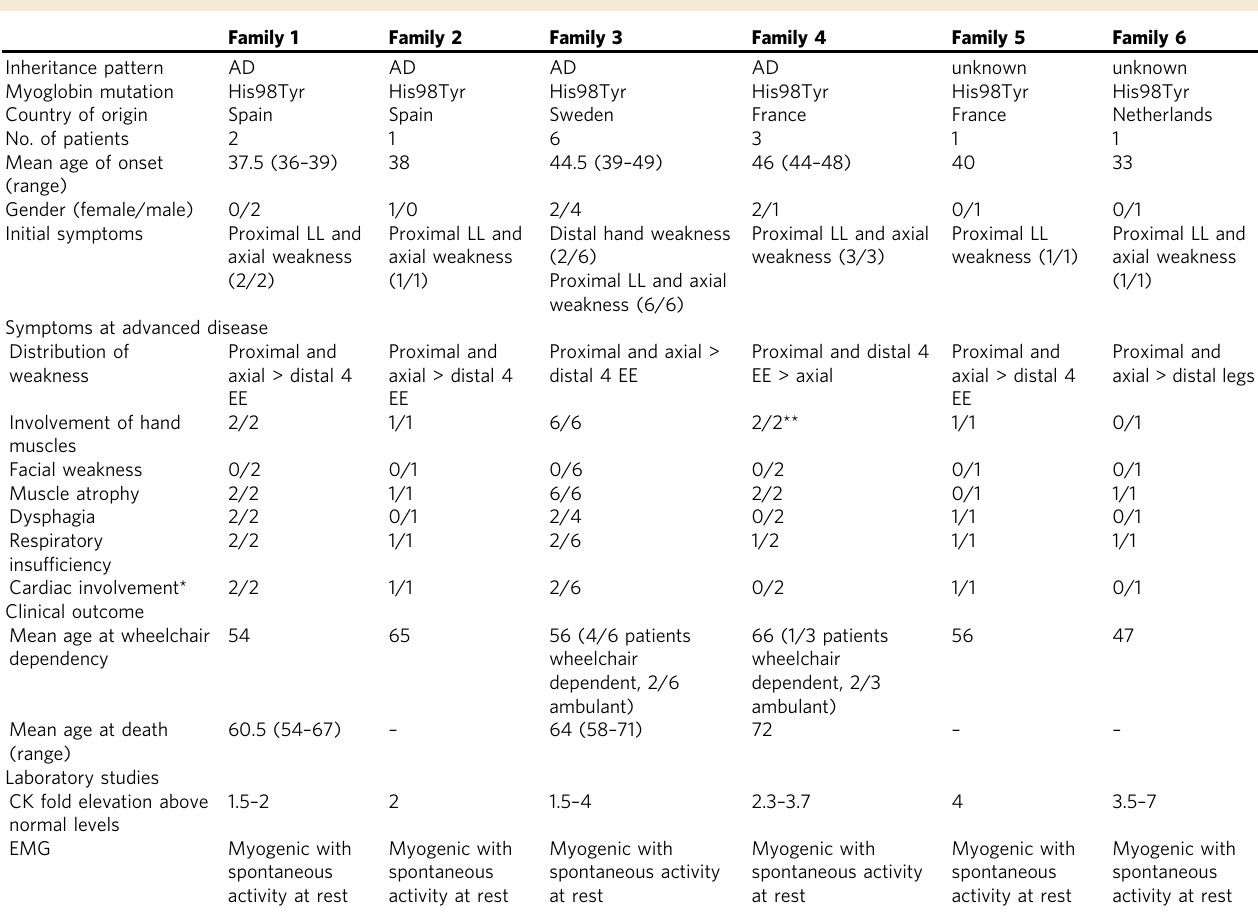
Table 1 Phenotypic features of